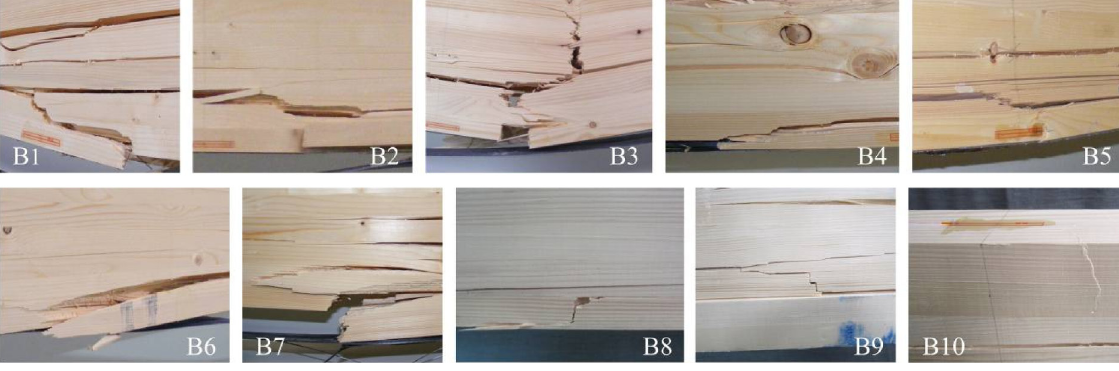
Fig. 2. Failure mechanism of Series B reinforced beams